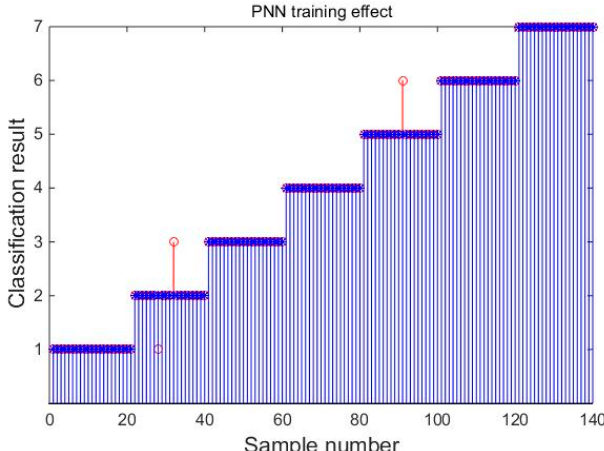
Figure 11. Training effect of PNN.